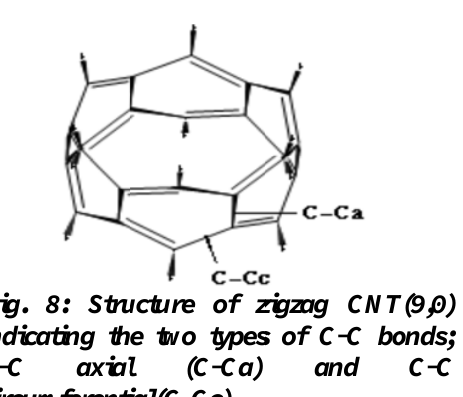
Fig. 7: Repet ngles of z quilibrium g oint group (D